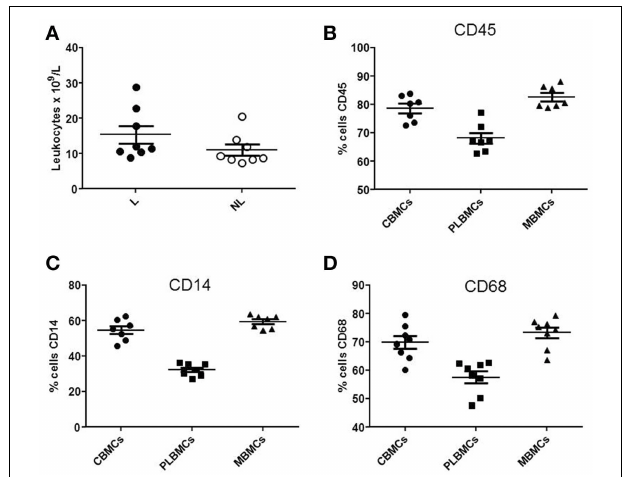
FIGURE 1 | Leukocyte populations in fetal and maternal blood. (A) Differences between cell marker expression in preparations of MBMCs, CBMCs, and PLBMCs using flow cytometry ( n = 6 –10 in each group). Leukocyte count in whole cord venous blood of L group and NL group was significantly different between the two the groups ( P < 0 . 05 ). (B) Scatter plot showing the percentage of CBMCs, PLBMCs, and MBMCs expressing (B) CD45, (C) CD14, and (D) CD68, determined by flow